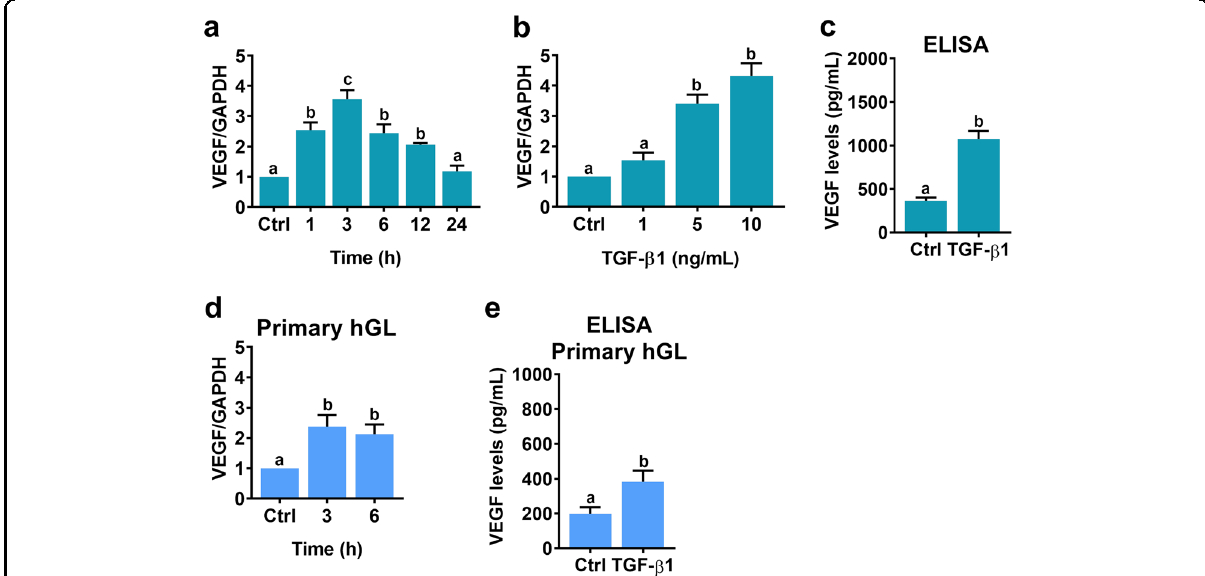
Fig. 1 TGF- β 1 stimulates VEGF expression in SVOG and primary hGL cells. a SVOG cells were treated with 5 ng/mL TGF- β 1 for different periods of time, and the mRNA levels of VEGF were examined by RT-qPCR. The level of VEGF mRNA at each time point was normalized to the GAPDH mRNA level at the same time point. b SVOG cells were treated with 1, 5, or 10 ng/mL TGF- β 1 for 6 h, and the mRNA levels of VEGF were examined by RT- qPCR. c SVOG cells were treated with 5 ng/mL TGF- β 1 for 24 h, and the protein levels of VEGF in culture media were examined by ELISA. d Primary hGL cells were treated with 5 ng/mL TGF- β 1 for 3 and 6 h, and then the mRNA levels of VEGF were examined by RT-qPCR. e Primary hGL cells were treated with 5 ng/mL TGF- β 1 for 24 h, and the protein levels of VEGF in culture media were examined by ELISA. The results are expressed as the mean ± SEM of at least three independent experiments. The values without a common letter are signi fi cantly different ( p <